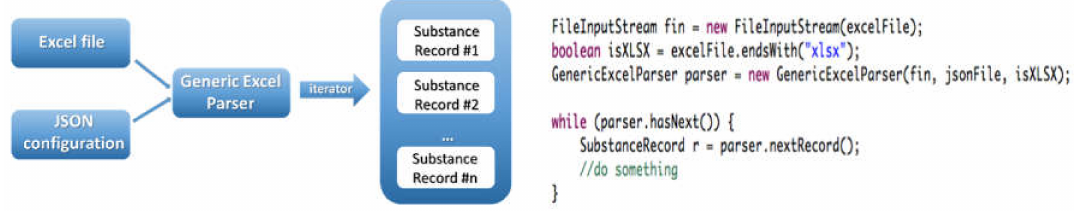
Figure 4. General usage of NMDataParser Java